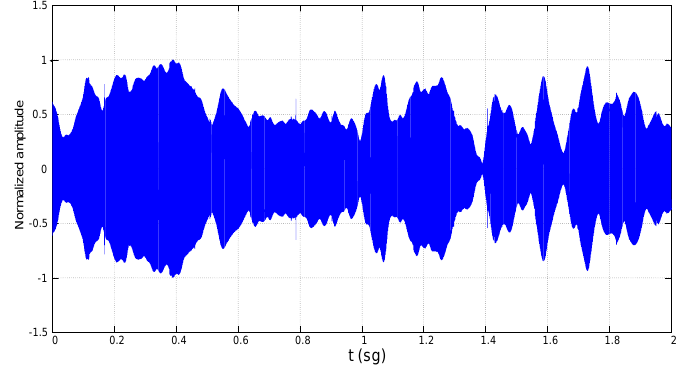
Figure 3. Segment of the received signal in Channel